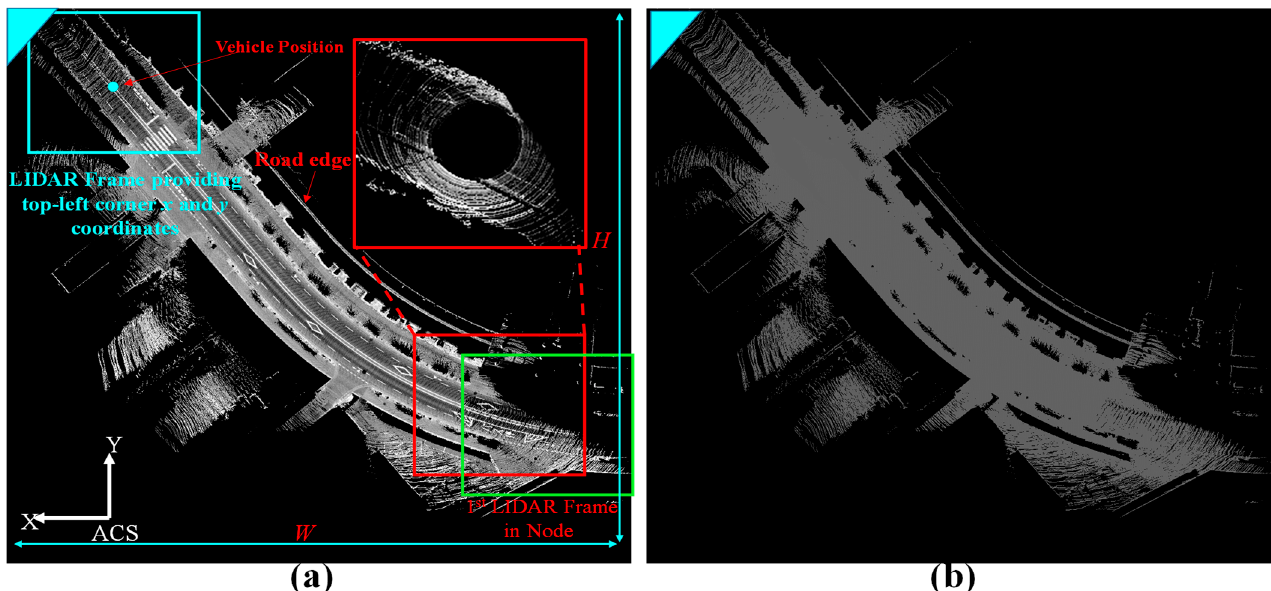
Figure 1. Node strategy. ( a ) Intensity image to represent the road surface by accumulating LIDAR frames according to the vehicle trajectory. Top-left corner is the identification of the node in the XY plane and determined by the maximum vehicle position in the driving area with respect to ACS. ( b ) Elevation image to express the height of each pixel in the road surface and identified in ACS by the average value.